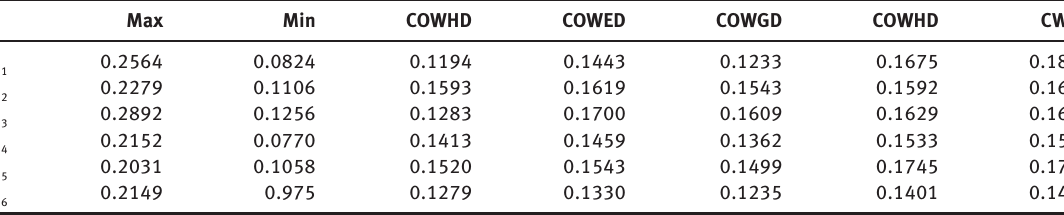
Table 7: Aggregated Result.